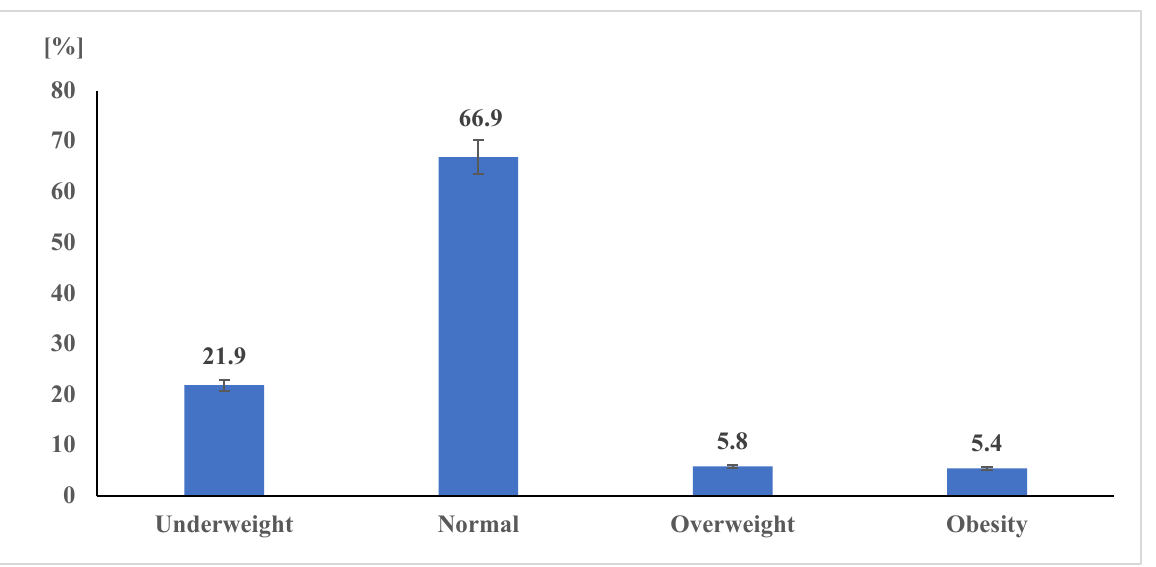
Figure 1. Descriptive statistics for the current prevalence of body weight status ( N = 3551; under- weight n = 778, normal weight n = 2377, overweight n = 205, obese n = 191).